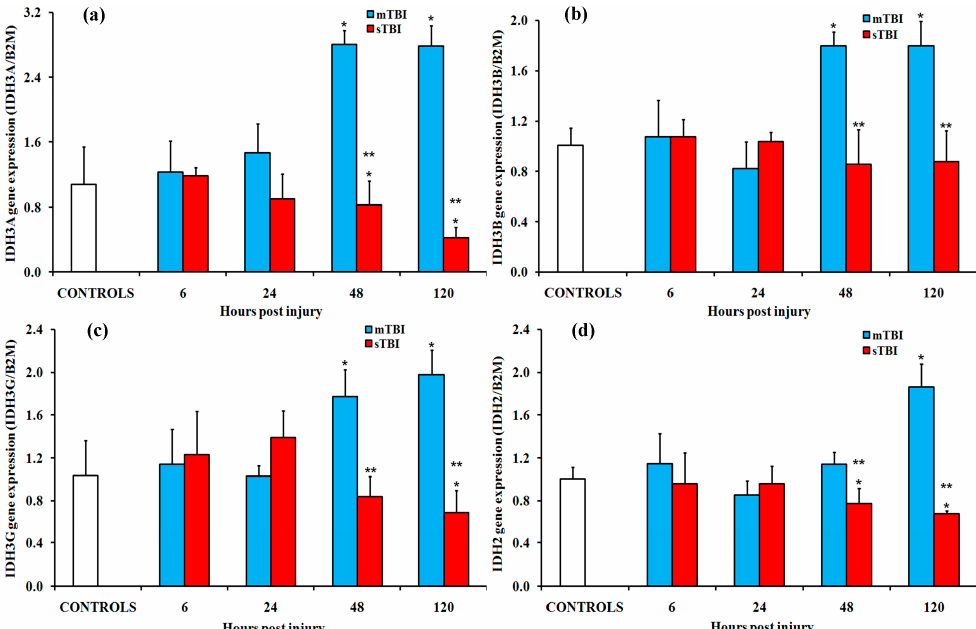
Figure 5. Changes in the expression of genes encoding for the subunits of the isoenzymes of isocitrate dehydrogenase (IDH) in the brain tissue homogenates of rats receiving a TBI of different severities (mTBI or sTBI) at various times post-injury. ( a ) IDH3A, the gene encoding for subunits alfa of the NAD + -dependent IDH isoform; ( b ) IDH3B, the gene encoding for subunit beta of the NAD + -dependent IDH isoform; ( c ) IDH3G, the gene encoding for subunit gamma of the NAD + -dependent IDH isoform; ( d ) IDH2, the gene encoding for the NADP + -dependent IDH isoform. Values are the mean of six animals. Standard deviations are represented by vertical bars. Gene expressions were calculated relatively to the expression of the housekeeping gene β -2-microtubulin (B2M). * significantly different from the controls, p < 0.05. ** significantly different from the corresponding time of the mTBI rats, p < 0.05.